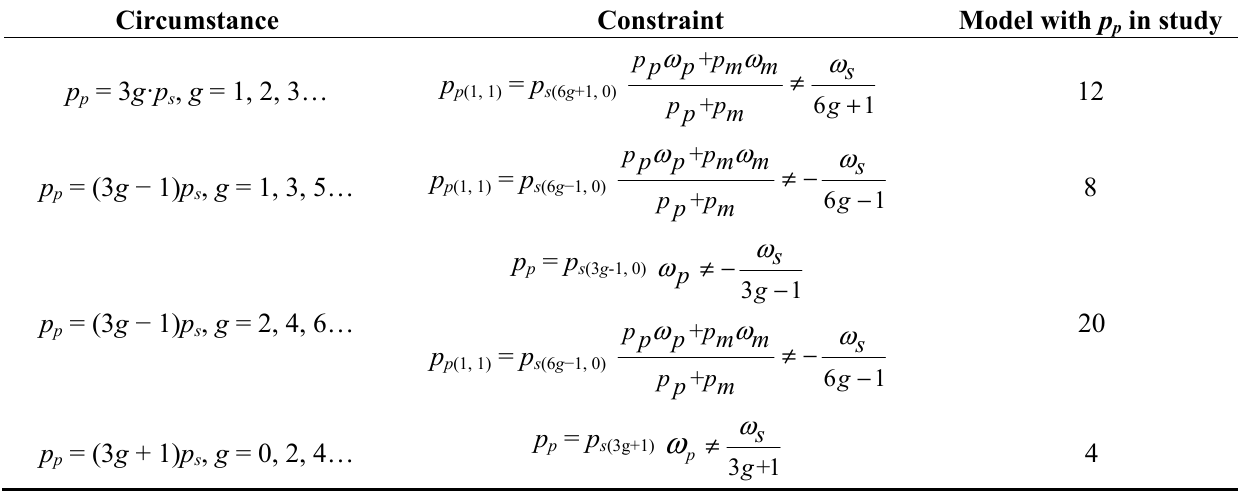
Table 1. Circumstance for significant electromagnetic torque ripple and constraint.